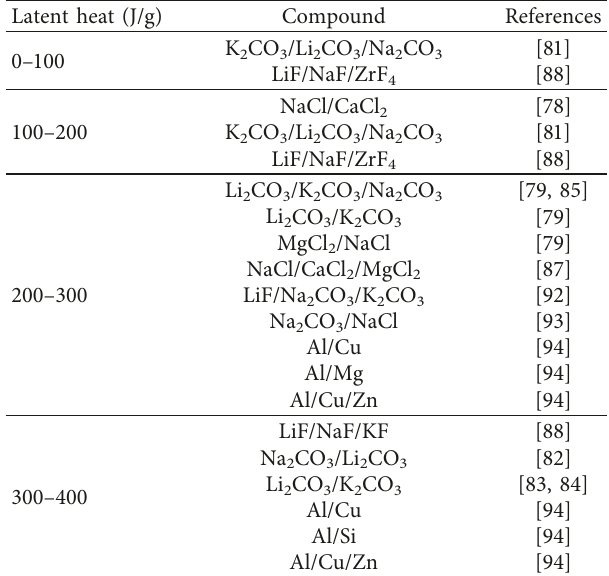
Table 6: The latent heat of high-temperature inorganic eutectic